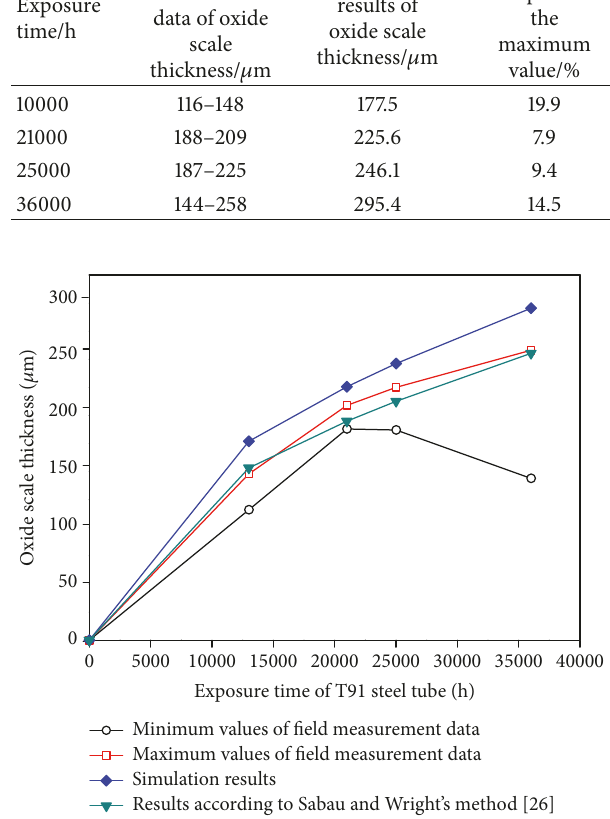
Figure 7: Comparison of the thickness of oxide scale of final super- heater tubes during the oxidation of T91 for different exposure time among field measurement data, simulation results, and calculation results according to Sabau and Wright’s method [26].